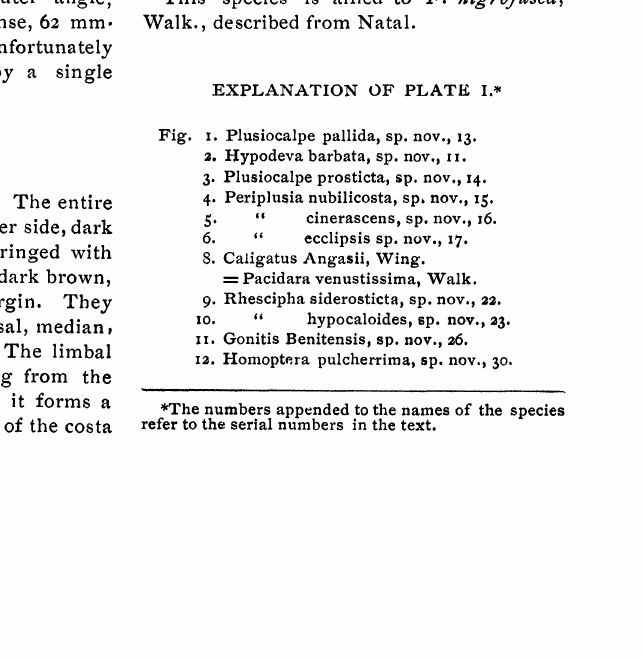
Fig. x. Plusiocalpe pallida, sp. nov., 3. z. Hypodeva barbata, sp.